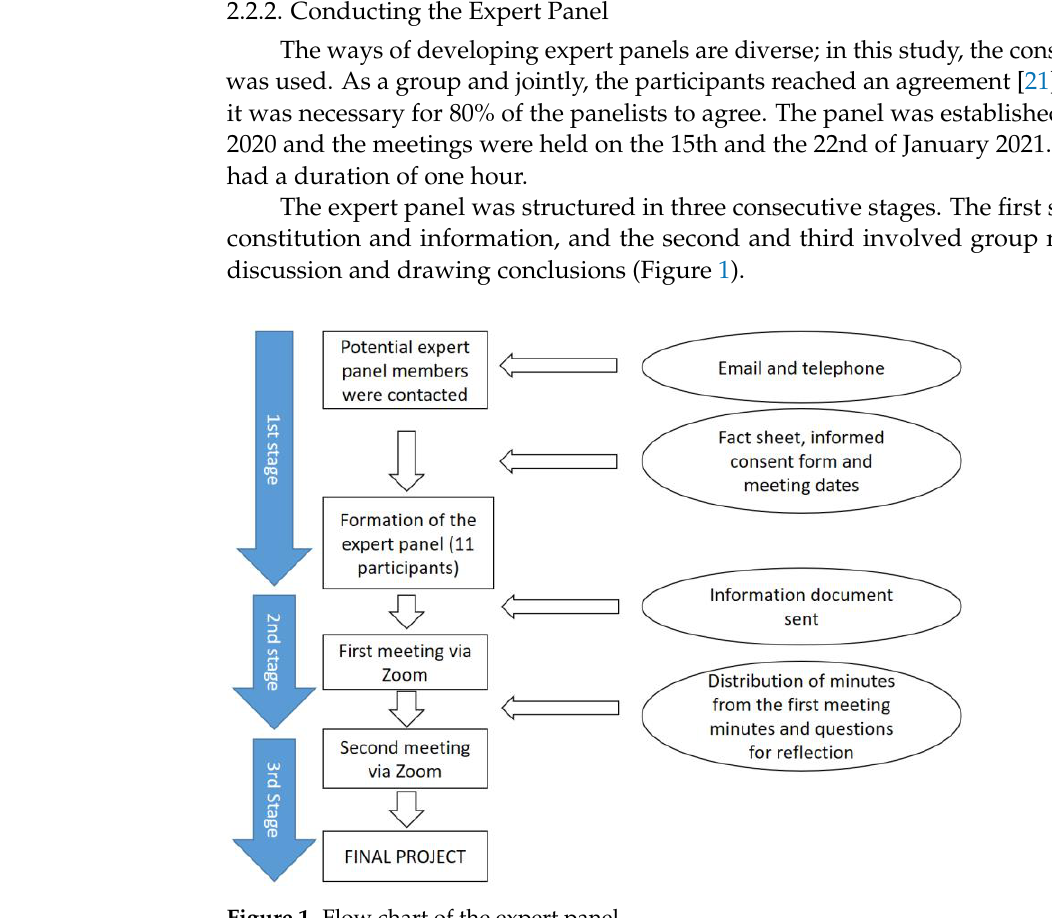
Figure 1. Flow chart of the expert panel.